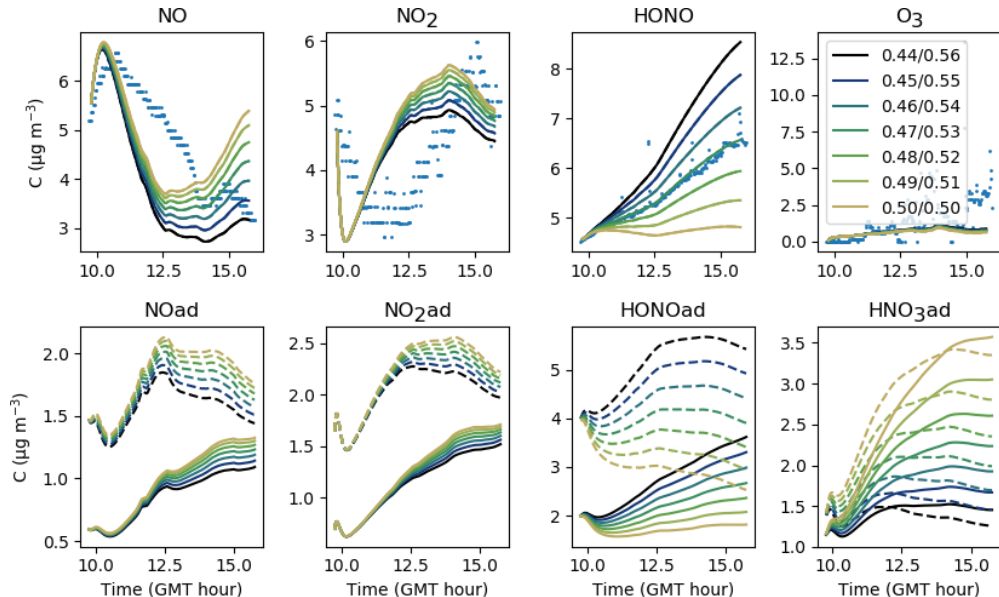
/β HONO , with β HNO /β HONO < 1. The blue dots 3 3